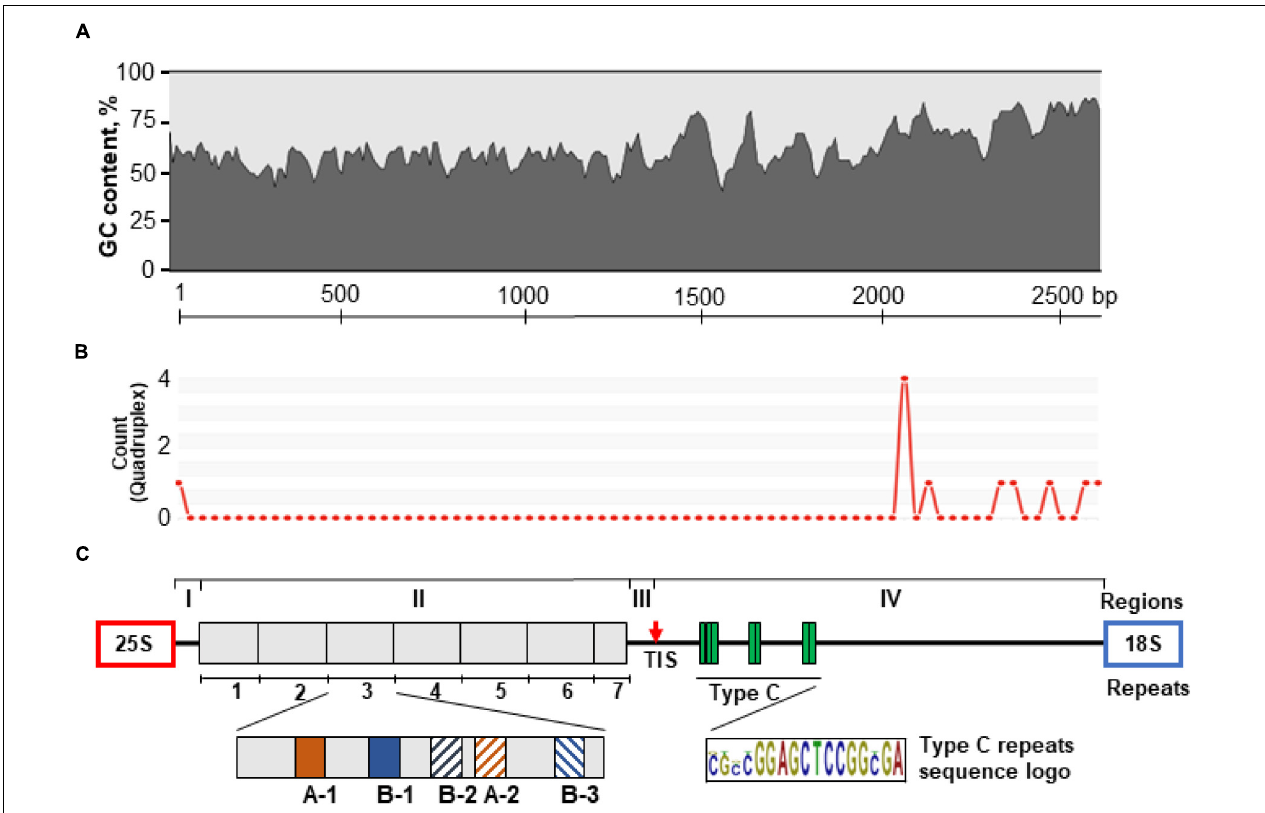
FIGURE 2 | Schematic representation of the molecular architecture of the 35S rDNA IGS of P. stratiotes obtained by sequencing the genomic clone Pi-IGS (accession no. OL409040). (A) Pattern of G + C nucleotide distribution along the IGS sequence calculated using window size of 45 nucleotides. (B) Patterns of G-quadruplex structures predicted for the IGS sequence using window size of 50 nucleotides; the heights of the peaks indicate the relative strength of each G-quadruplex structure. (C) The IGS is divided into four regions (I–IV); region II contains seven repeats (1–7) composed of subrepeats A-1, A-2, B-1, B-2, and B-3; region III has a transcription initiation site (TIS), marked by a red arrow; region IV, which corresponds to the 5 (cid:48) -ETS, contains Type C subrepeats with the consensus sequence